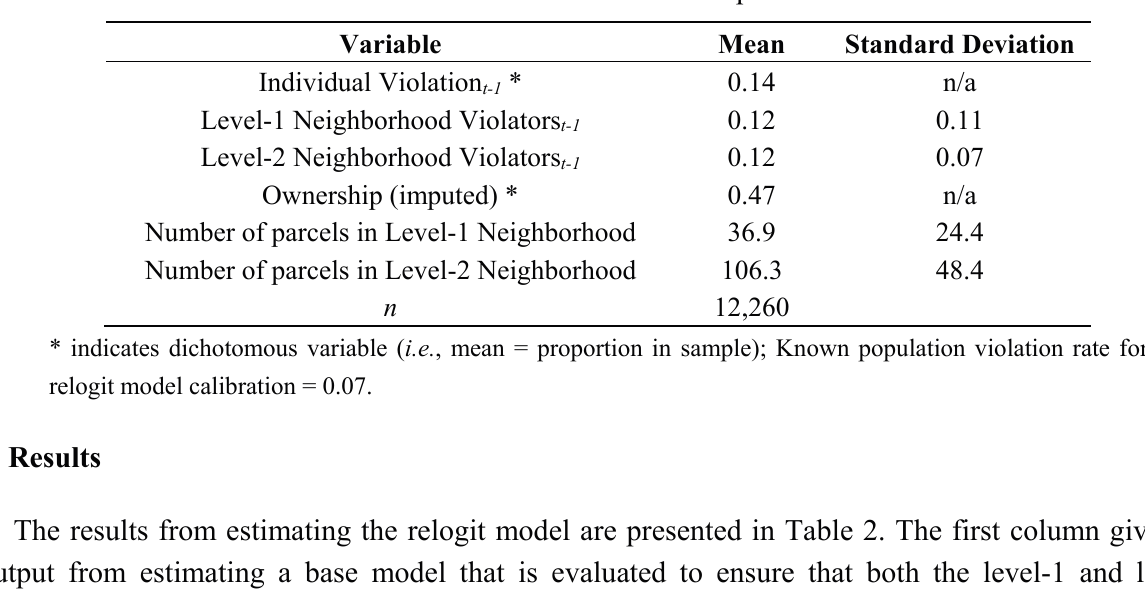
Table 1. Characteristics of sample data.